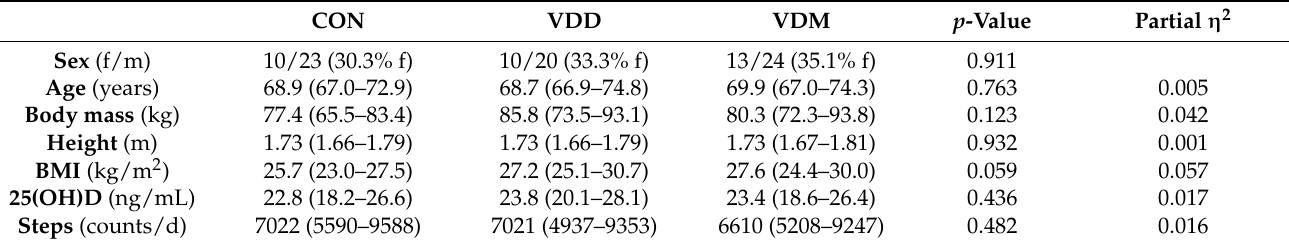
Table 1. Baseline characteristics of